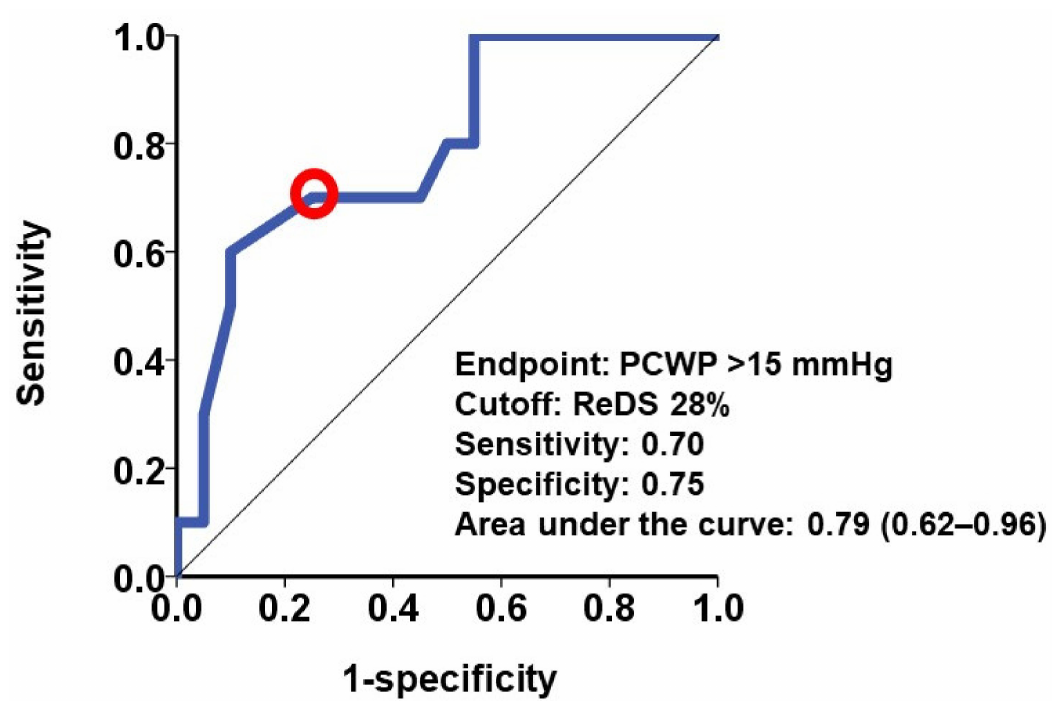
Figure 3. Receiver operating characteristics analysis for ReDS values to estimate PCWP > 15 mmHg. A red circle indicates the cutoff of ReDS